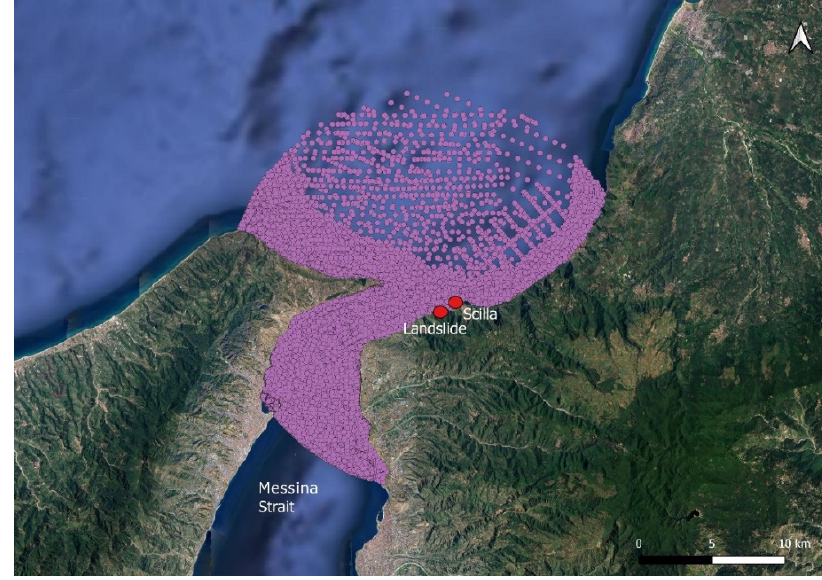
Figure 8. Domain of IGM bathymetry (purple dots) for the event of 1783.